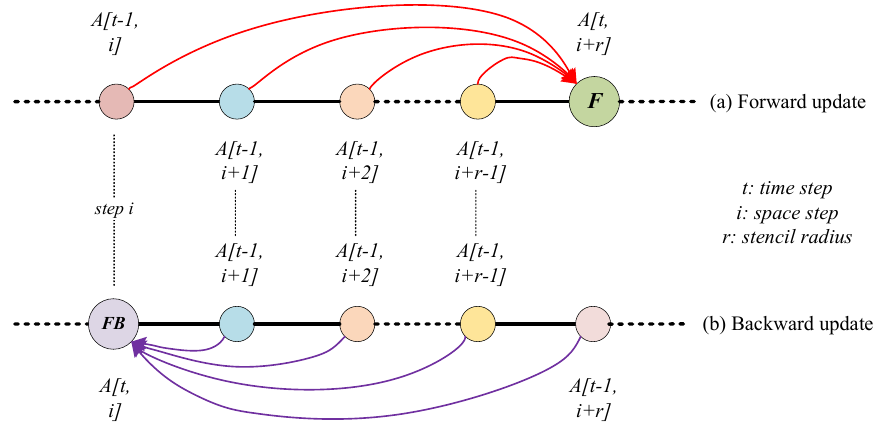
Figure 4. Detail of the two phases for the semi-stencil algorithm at step i